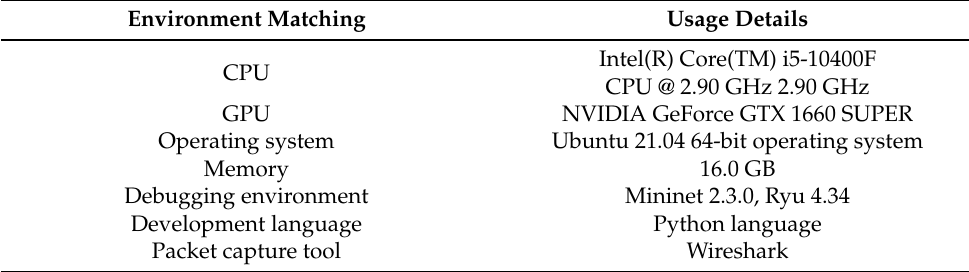
Table 1. Environment Configuration